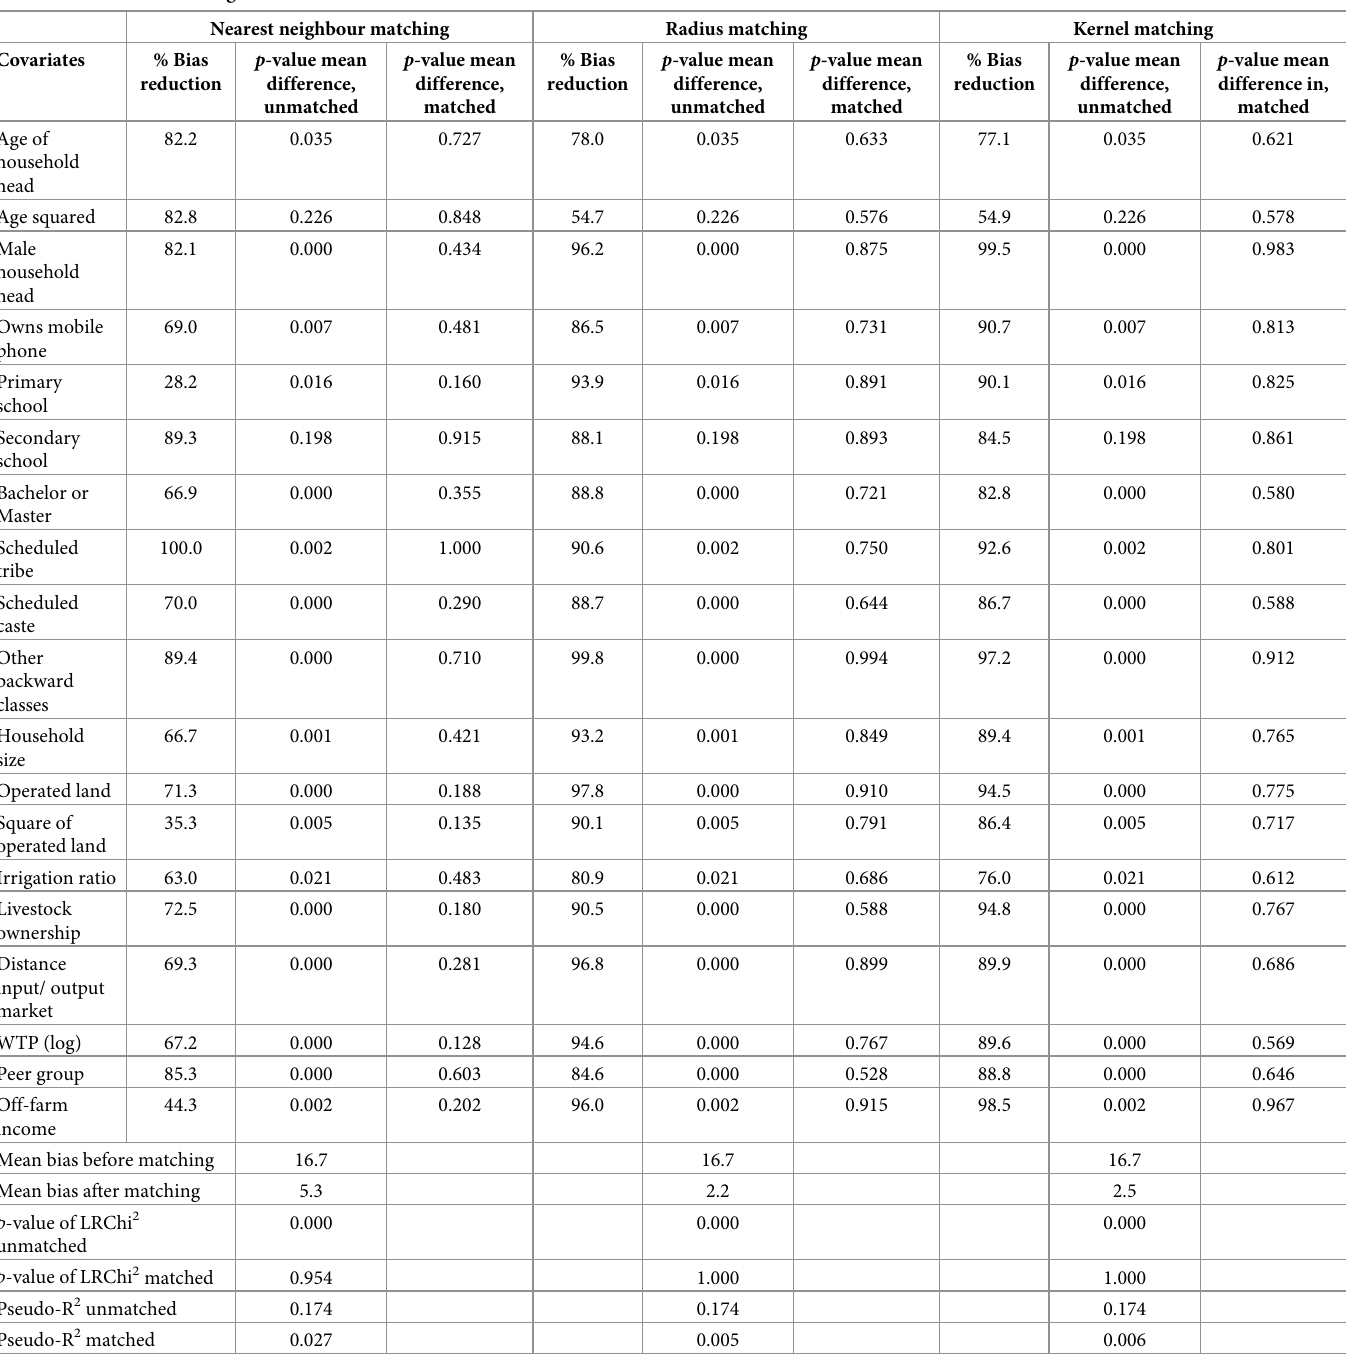
Table 4. Covariate balancing